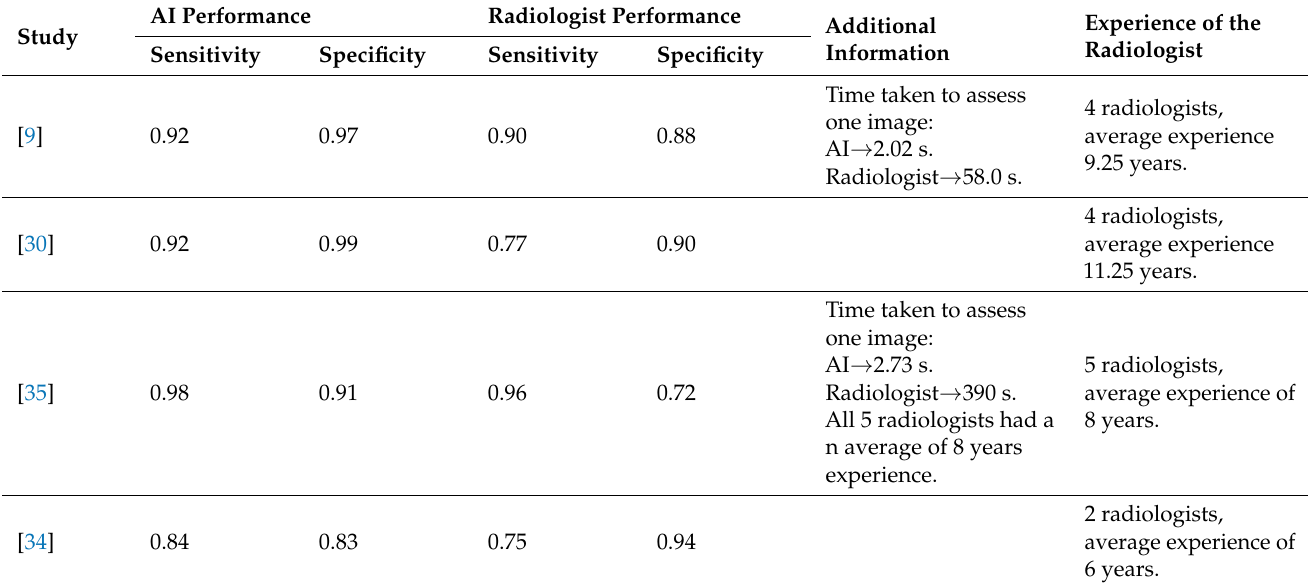
Table 7. Overview of AI and radiologist performance in studies with radiologist as comparator.